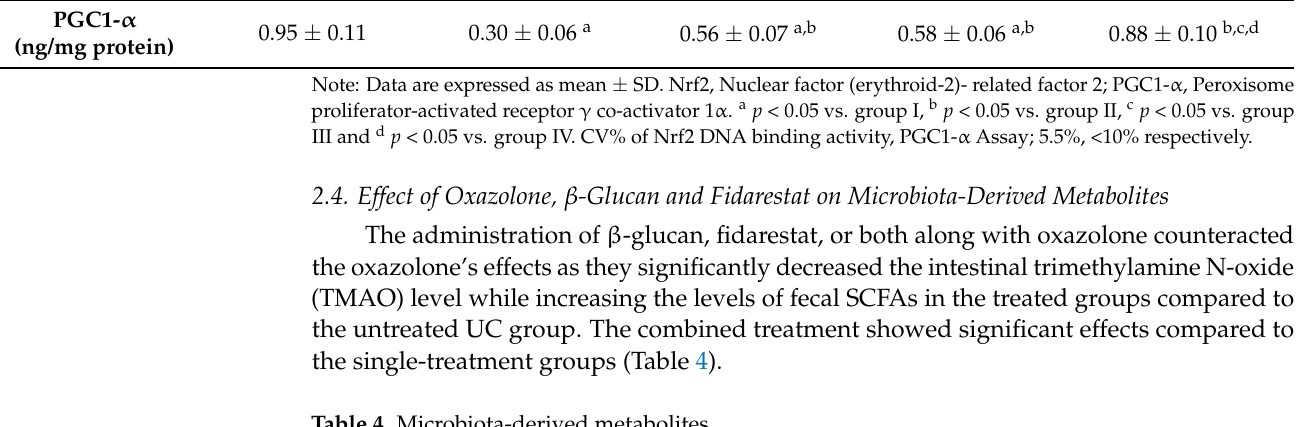
Table 4. Microbiota-derived